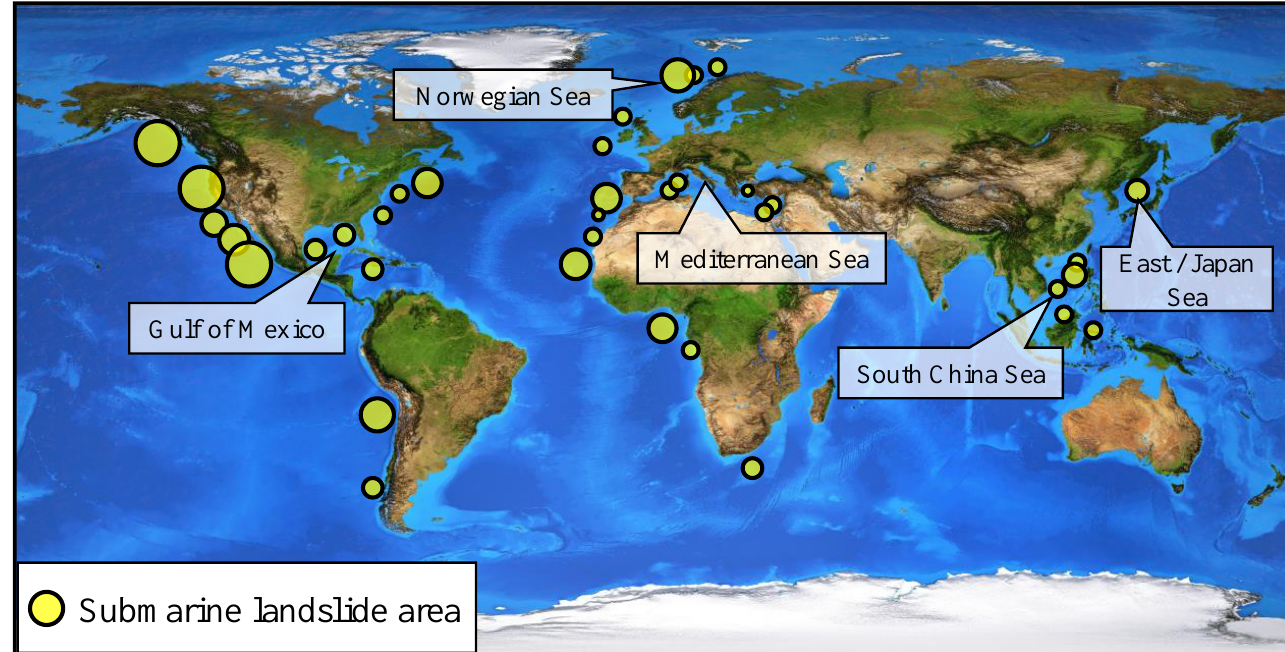
Figure 1. Regional distribution of main areas for submarine landslides. Modified from [15].